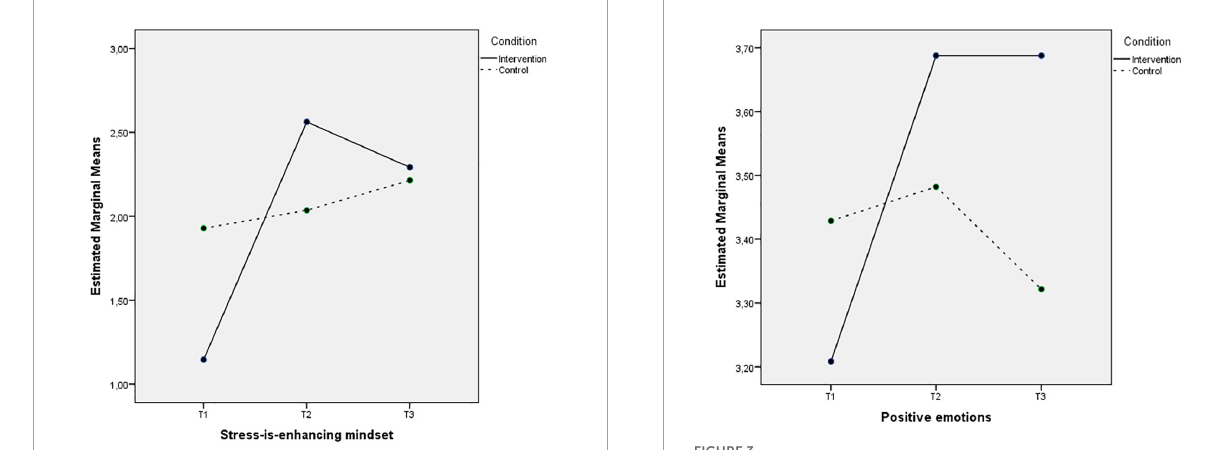
FIGURE3 Mean of positive emotions showing time effects on the two conditions.